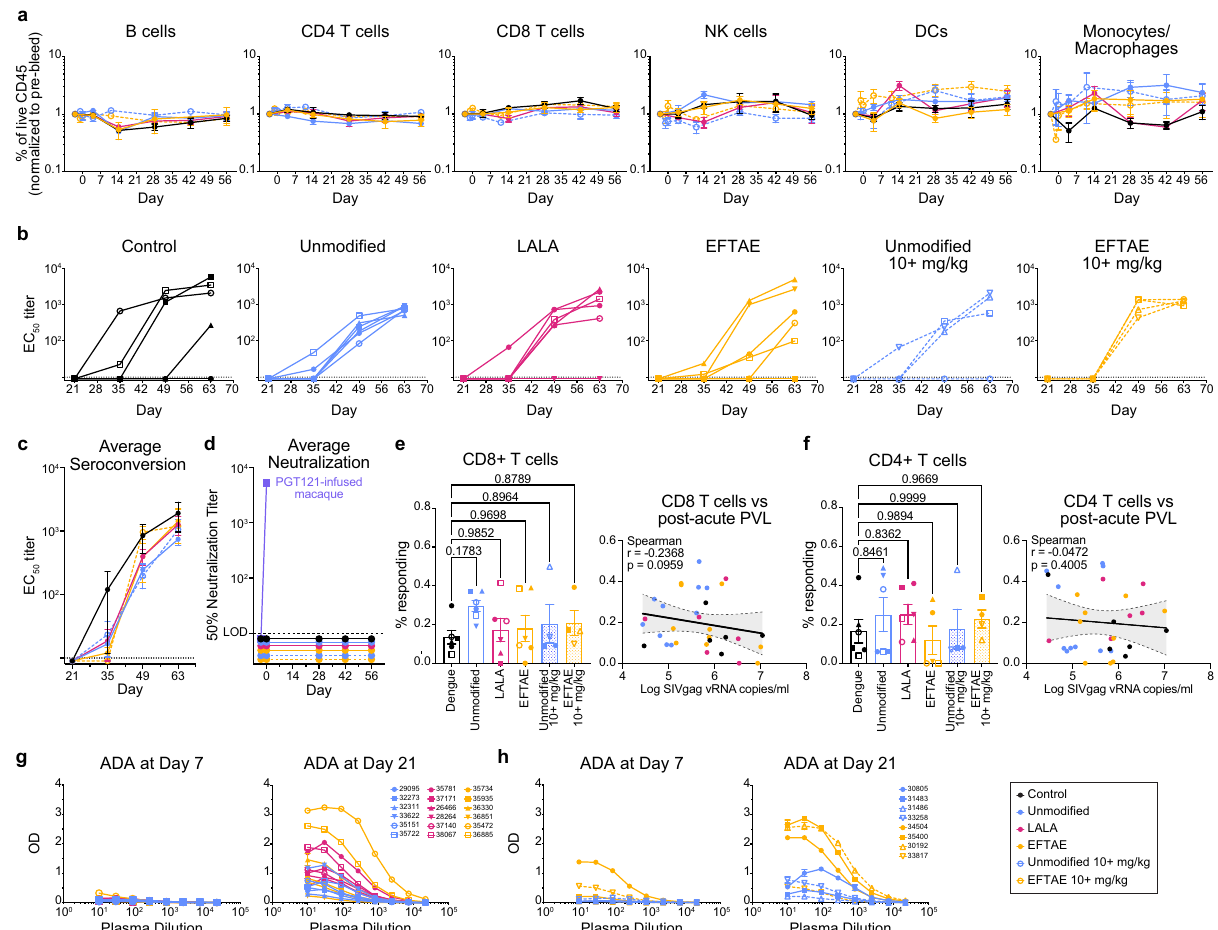
Fig. 7 Endogenous immune responses and ADA in macaques. a Mean± se of cell subsets as the percent of live CD45 + in each treatment group normalized to the percentage composition prior to bNAb treatment. b Individual or c mean ± se longitudinal plasma binding titers to HIV SF162 gp140 measured by ELISA. d Average longitudinal neutralization IC 50 values from each group against the replication-competent SHIV SF162P3 challenge stock measured in the TZM-bl assay. Plasma from a macaque infused with bNAb PGT121 was used as an assay control. e , f Intracellular cytokine staining on PBMCs collected from study day 56 and incubated with SIV mac239 gag pooled peptides. Data are reported as the percent CD8 + or CD4 + of the CD3 + CD45RA- IFN γ + population in peptide-stimulated minus that in mock-stimulated cultures. Individual values are plotted by treatment group, with bars showing mean ± se, and on correlation matrices with post-acute viral load, where r and p are derived from one-tailed Spearman tests and visualized with a simple linear regression line. g Plasma from each macaque treated with 5 mg/kg and h 10 or 20 mg/kg 10E8v4 was tested for the development of ADA 10 days (study day 7) and 24 days (study day 21) after injection via ELISA. Statistical comparisons were performed using repeated-measures one-way ANOVA ( a , e , f ) with multiple comparisons followed by Dunnett ’ s post-hoc test, and no statistically signi fi cant differences were found between treatment and control groups. Data and analysis are derived from n = 6 animals per group (5 mg/kg); n = 4 animals per group (10 + mg/kg). Statistical signi fi cance was determined at the signi fi cant alpha level of 0.05 and performed in GraphPad Prism 9. Symbols denoting individual macaques in e – g are shown in Figs. 4 and 5. Animal symbols and group colors are consistent throughout the manuscript. Data are representative of at least two independent experiments. Source data are provided in the Source Data fi le associated with this manuscript. ADA anti-drug